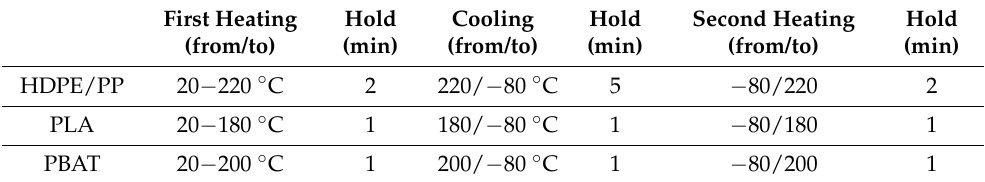
Table 1. DSC programs for the polymers. Rate of the scans: 10 ◦